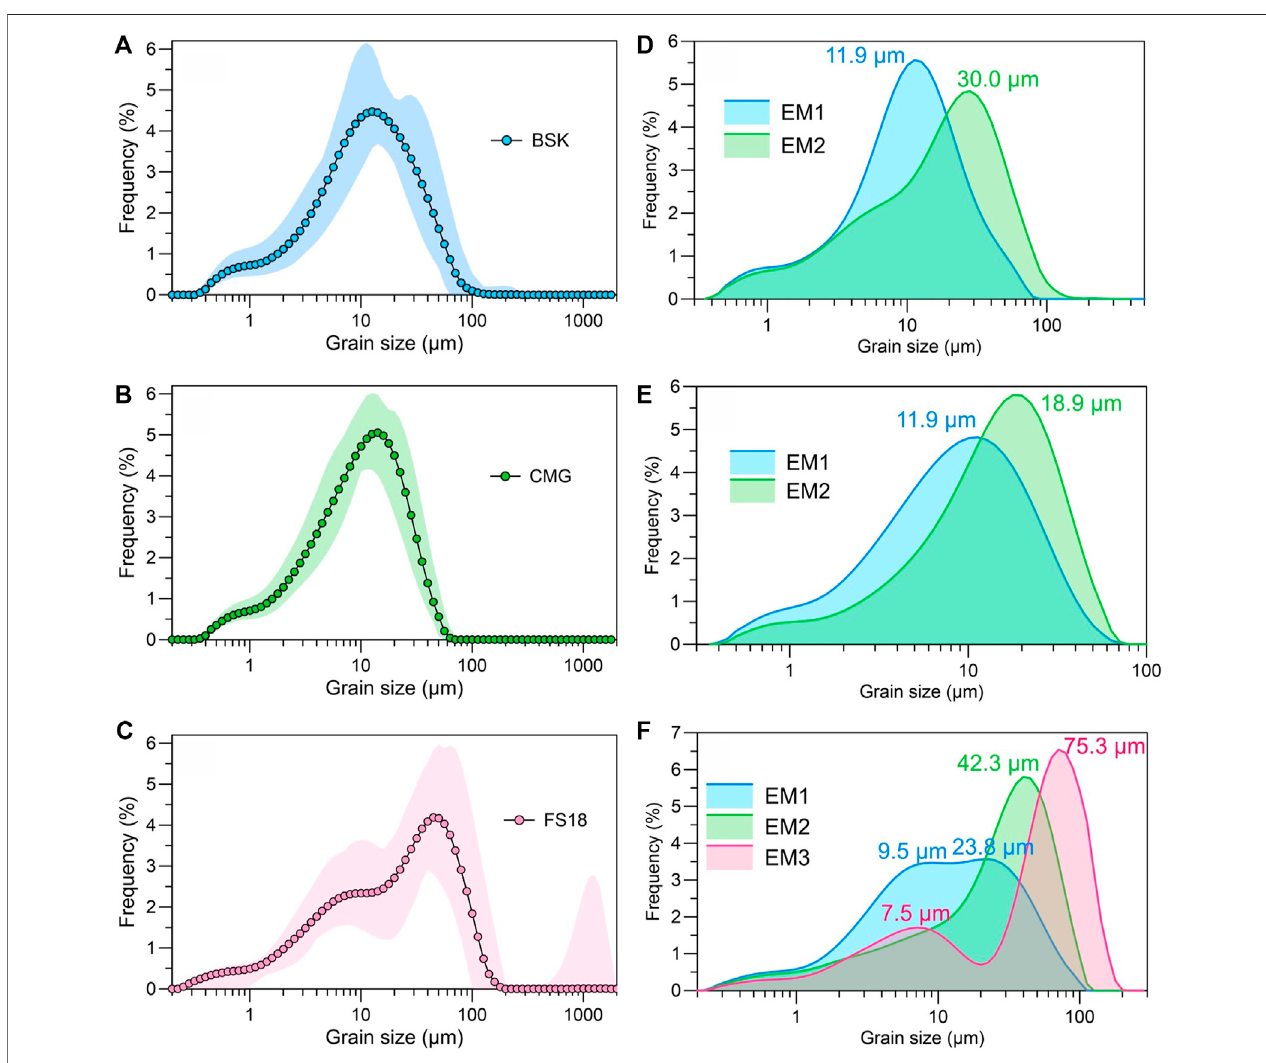
FIGURE4| MeangrainsizedistributionandrangeofvolumefrequencyforeachsizeclassinloessfortheBSK (A) ,CMG (B) ,FS18 (C) loesssections,andgrainsize partitionedcomponentsoftheBSK (D) ,CMG (E) ,andFS18 (F) loess.TheminimumandmaximumvaluesoftheGSDs[coloredshadein (A) , (B) , (C) ]werefoundineach size class and the averages refer to the mean volume frequencies of each size class.